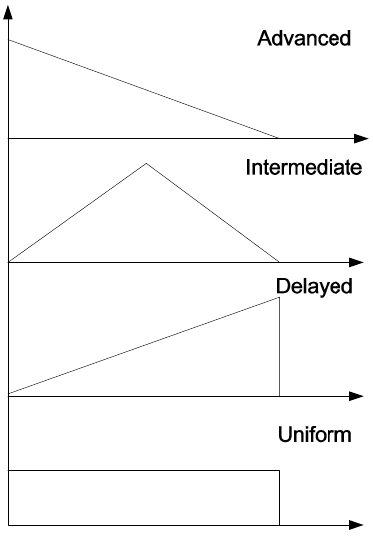
Figure 12. The four representative rainfall patterns [11].